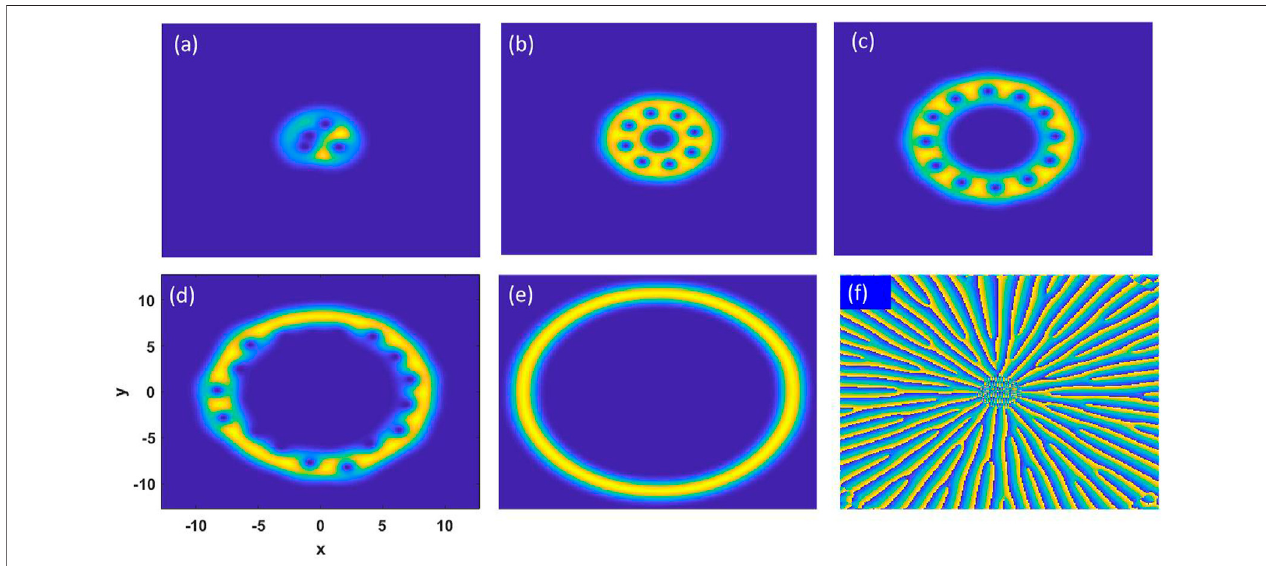
FIGURE 1 | Typical ground-state structures of a rotating BEC as a function of the gradient magnetic fi eld in the absence of SU(3) spin – orbit coupling. (A) – (E) Density distributions of component 1 for different gradient magnetic fi elds: (A) B (cid:1) 0, (B) B (cid:1) 1, (C) B (cid:1) 2, (D) B (cid:1) 3, and (E) B (cid:1) 4. (F) The corresponding phase distribution of (C) . Other parameters are fi xed as c 0 (cid:1) 100, c 2 (cid:1) 3, Ω (cid:1) 0.7, and κ (cid:1) 0, and the scale of each fi gure is [ − 12.8,12.8] in units of l ⊥ (cid:1) [ Z / M ω ⊥ ] 1/2 .